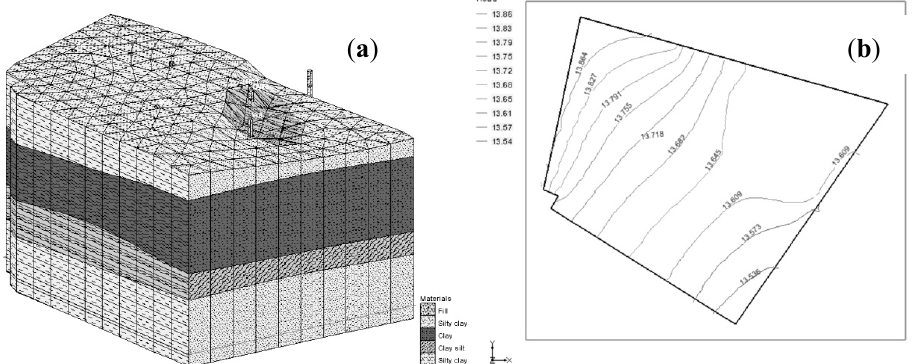
Figure 2. ( a ) The geological model for the LuHe site; ( b ) groundwater contour map of the unconfined aquifer (unit of head: m).